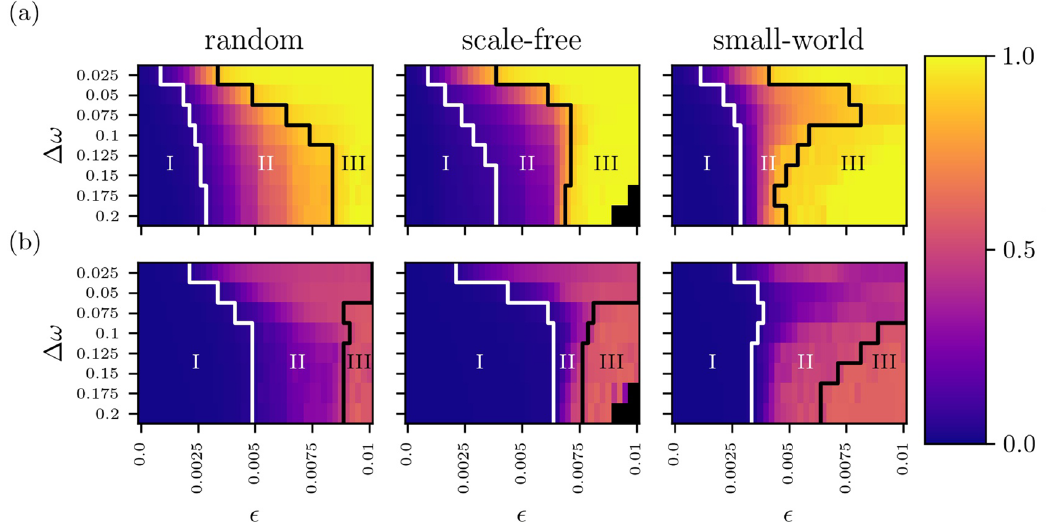
Figure 1. Average strength of interaction between oscillators (Eq. 2), “Methods” for various coupling topologies, coupling strengths ε , and frequency inhomogeneities �ω . Strength of interaction estimated with maximumlag cross correlation σ ( a ) and with mutual information µ ( b ). Averages ( (cid:31) σ (cid:30) resp. (cid:31) µ (cid:30) ) derived from all non-redundant pairs of oscillators in a given network (size V = 50 ) and from 20 realizations of network dynamics. For each realization of a coupling topology, initial conditions of oscillators were chosen randomly near the attractor. Coupling topologies are of random (left), scale-free (middle), or small-world type (right). Coupling strength ε was varied from 0 to 0.01 in steps of 0.0002 and frequency inhomogeneity �ω (width of the normal distribution of natural frequencies) from 0.025 to 0.2 in steps of 0.025. Outlined areas mark different regimes of coupling strengths (regime I: low, regime II: intermediate, and regime III: high). Black-colored pixels indicate parameter settings for which we only observed oscillation/amplitude death. Note, that the latter phenomenon is observed for high-degree nodes in networks with scale-free topologies. When increasing (decreasing) network size while keeping edge density constant, the borders between the regimes shift to lower (higher) coupling strengths and the distances between borders shrink (enlarge). Similar results can be expected for other types of oscillator dynamics 77